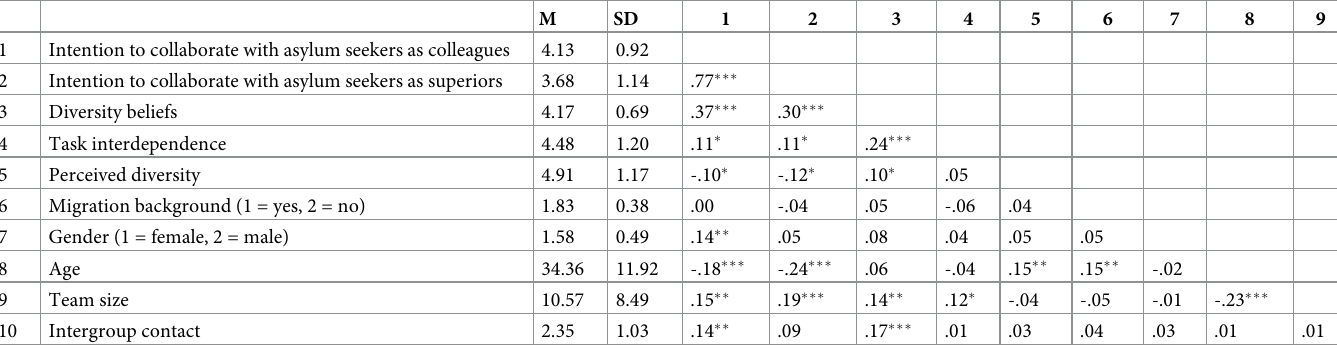
Table 1. Means, standard deviations, and correlations between variables on the individual